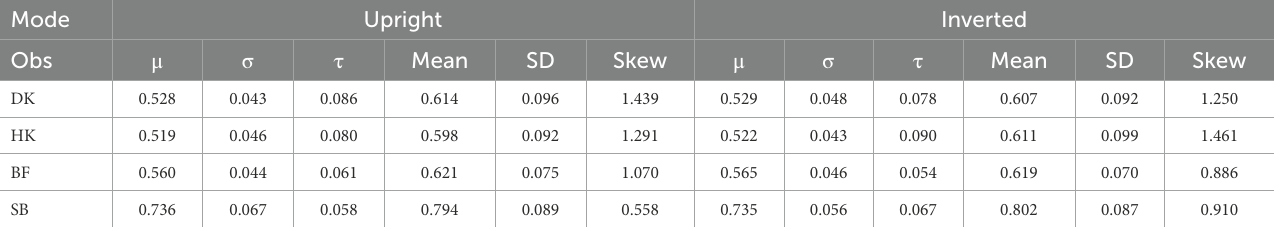
Mode Upright Inverted